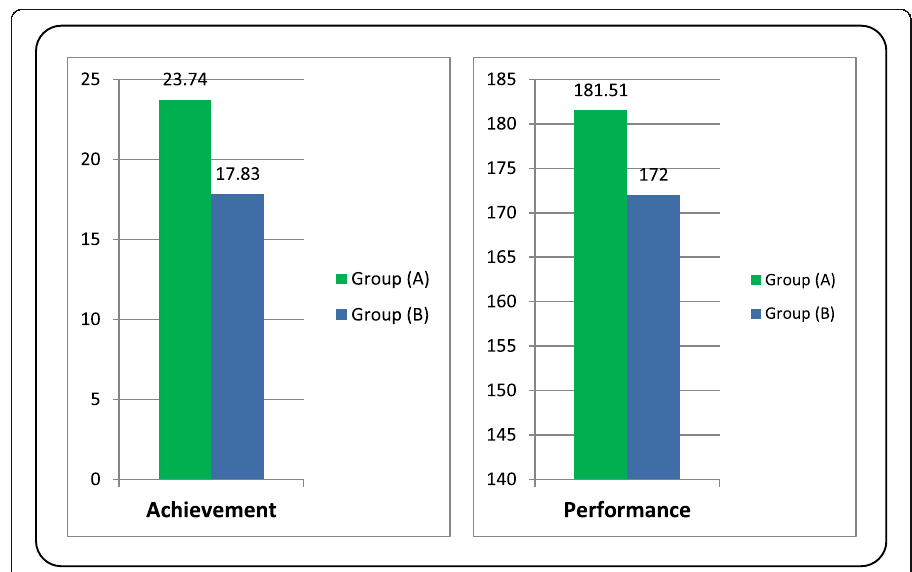
Fig. 10 The differences between scores of group A and group B in the post-test of achievement and